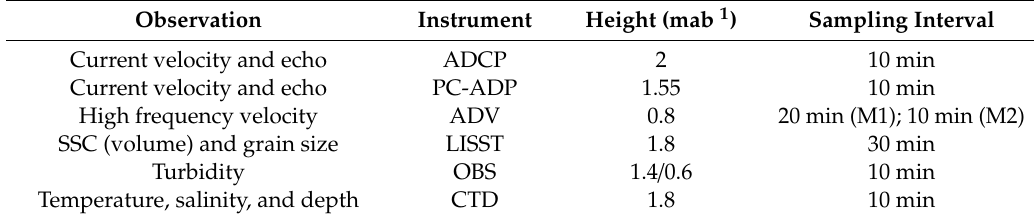
Figure 2. Seabed observation platform. Note: ADV, acoustic Doppler velocimeter, ADCP, acoustic Doppler current profiler; PC-ADP, pulse-coherent acoustic Doppler profiler; LISST, laser in situ scattering and transmissometry; OBS, optical backscatter sensor; CTD, conductivity temperature depth sensor. Table 1. Overview of instrument